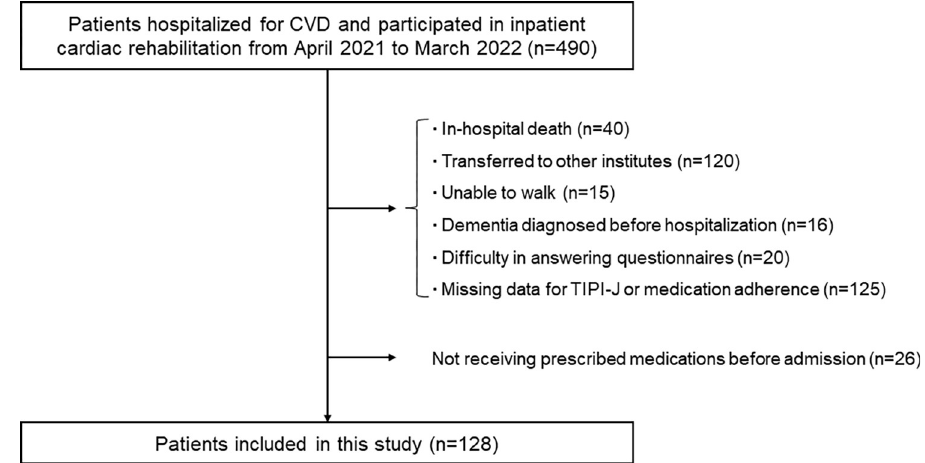
Fig 1. Flowchart of the study participants. CVD, cardiovascular disease; TIPI-J, Japanese version of the Ten-Item Personality Inventory.